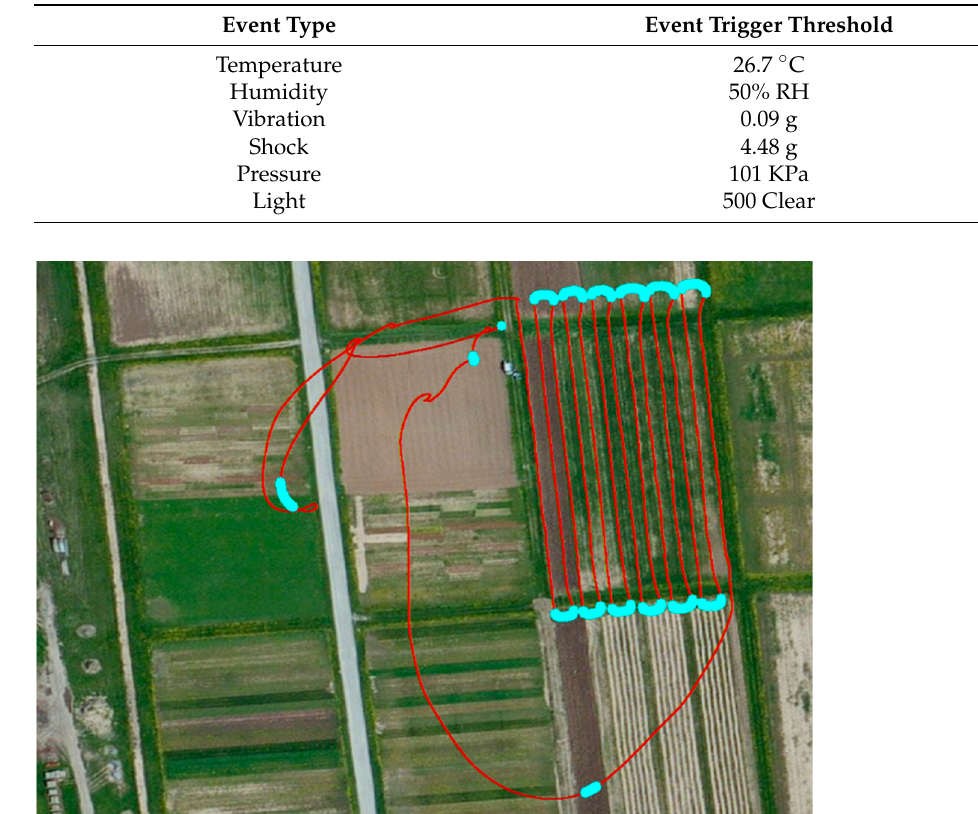
Figure 3. Cruise route of the DJI Matrice 600 Pro.